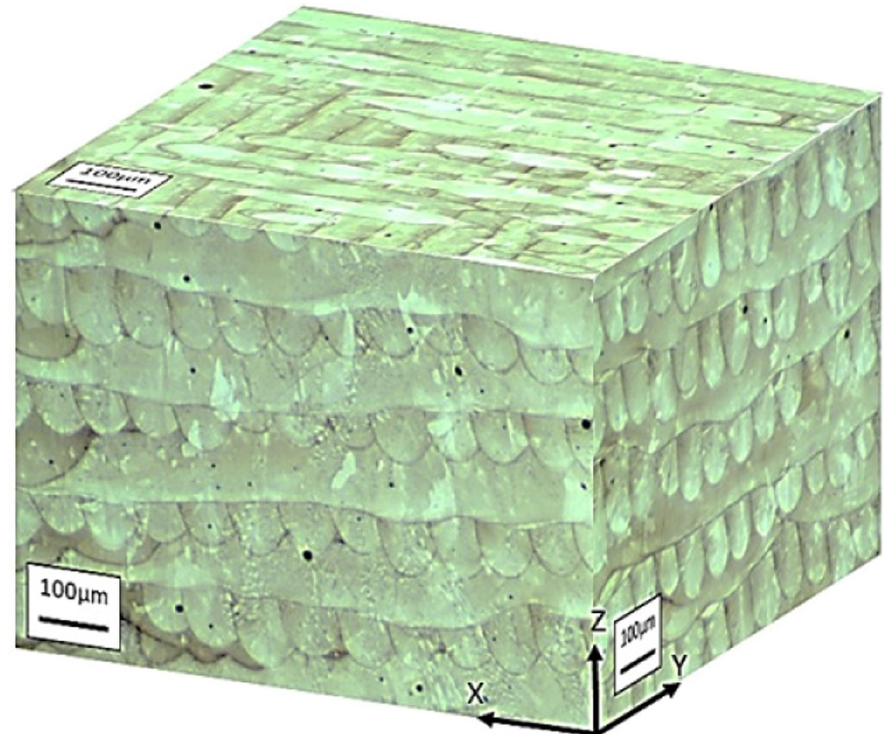
Figure 10. Optical metallographic image of Ni-base superalloy Inconel 718 obtained with SLM in as-built condition. The build direction is indicated by Z axis [46]. Copyright 2018 Elsevier.